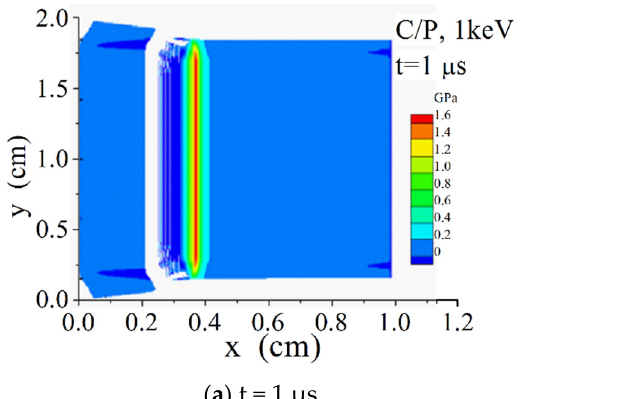
Figure 9. σxx (GPa) contours of C/P under radiation of X-ray with 1 keV blackbody spectrum. ( a ) t = 1 us; ( b ) t = 2 us.